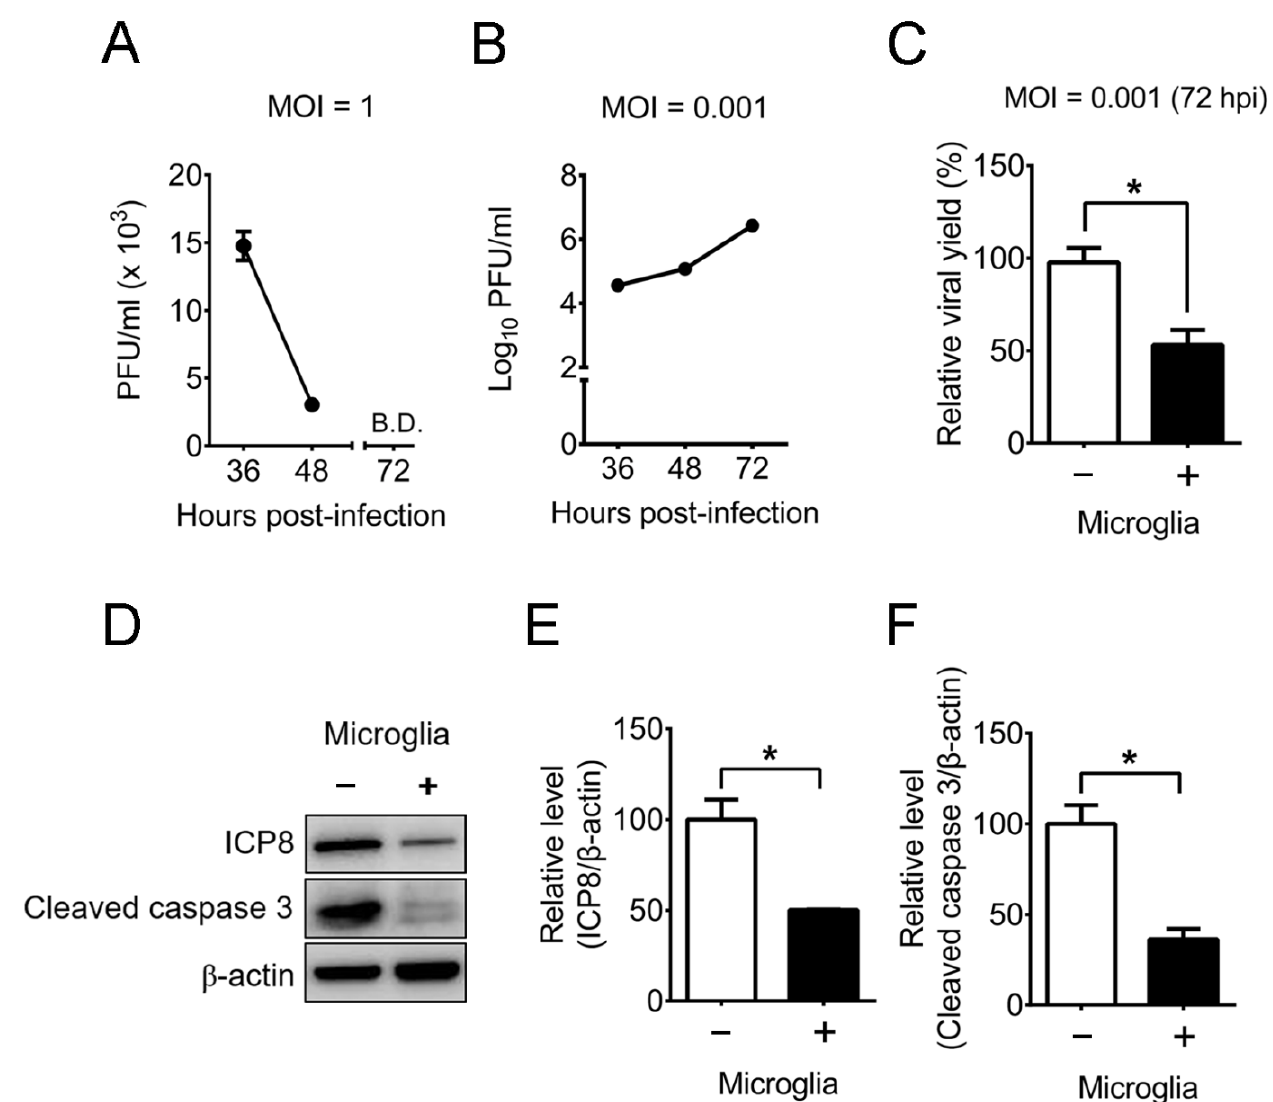
Figure 7. Mouse primary brain microglia reduce HSV-1 replication and apoptosis of mouse primary brain neurons. ( A ) Microglia and ( B ) neurons (1 × 10 5 cells) cultured from mouse brains were infected with HSV-1 at the indicated MOIs and harvested for virus titration. B.D., below the detection limit. ( C ) Neurons (1 × 10 5 cells) were co-cultured without ( – ) or with (+) 1 × 10 5 microglia, infected with HSV-1 (MOI = 0.001), and harvested 72 h post-infection for virus titration. ( D – F ) Samples prepared as described in ( C ) were assayed for HSV-1 protein (ICP8), cleaved caspase 3, and β -actin by Western blotting. The levels of ICP8 or cleaved caspase 3 normalized to β -actin are shown. The means of neuron groups were set as 100% ( C , E , F ). The data represent means ± or + SEM (error bars) of 4–5 samples per data point and 3–16 samples per group obtained from at least two independent experiments. *, p < 0.05.